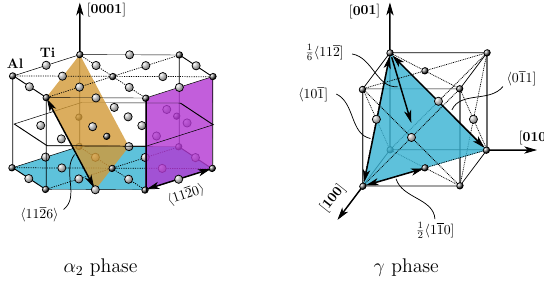
Figure 2. Crystallographic lattices of constituent phases with most relevant deformation mechanisms. left: hexagonal D0 19 lattice of α 2 phase (Ti 3 Al); right: tetragonal L1 0 lattice of γ phase (TiAl).